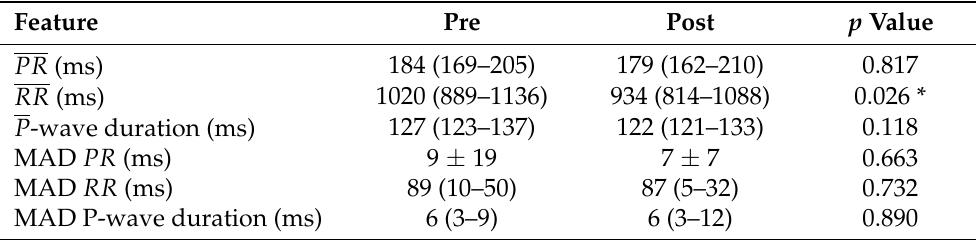
Table 3. Pre- and post-PVI time-interval measurements, and average MAD about mean for the whole study population (50 subjects). Data are mean ± standard deviation or median (interquartile range).